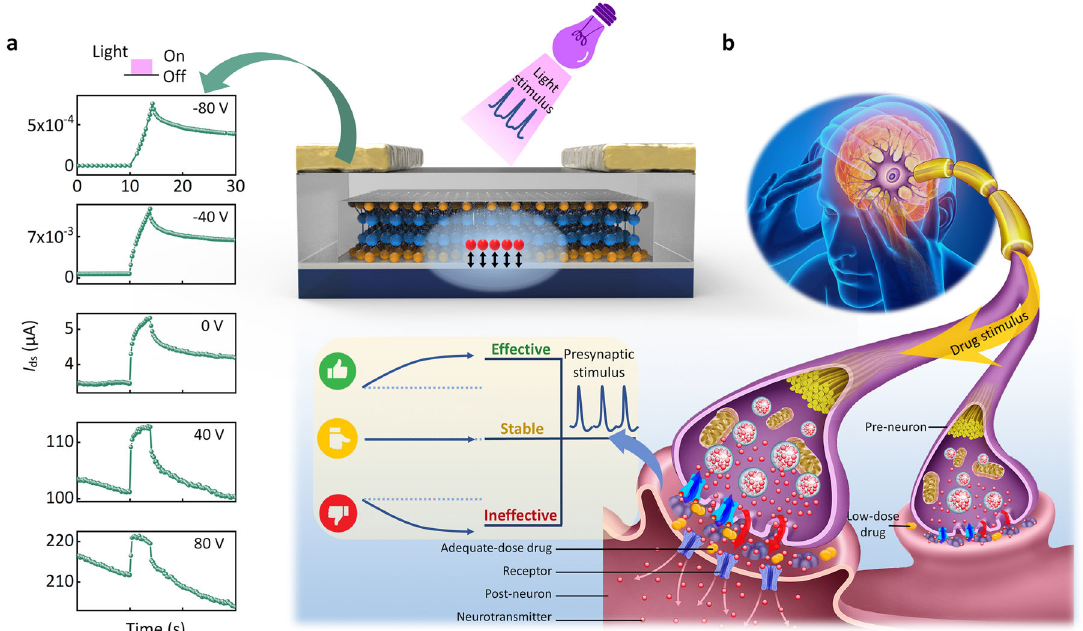
Fig. 2 Gate voltage-dependent electrical property and schematic diagram of the synaptic response mechanism. a Drain-source currents ( I ds ) of the InSe synaptic device at gate voltages of − 80, − 40, 0, 40, and 80 V and drain-source voltage of 0.5 V. b Schematic diagram illustrating the synaptic response mechanism and three outcomes of drug action in the nervous system. Used with permission from